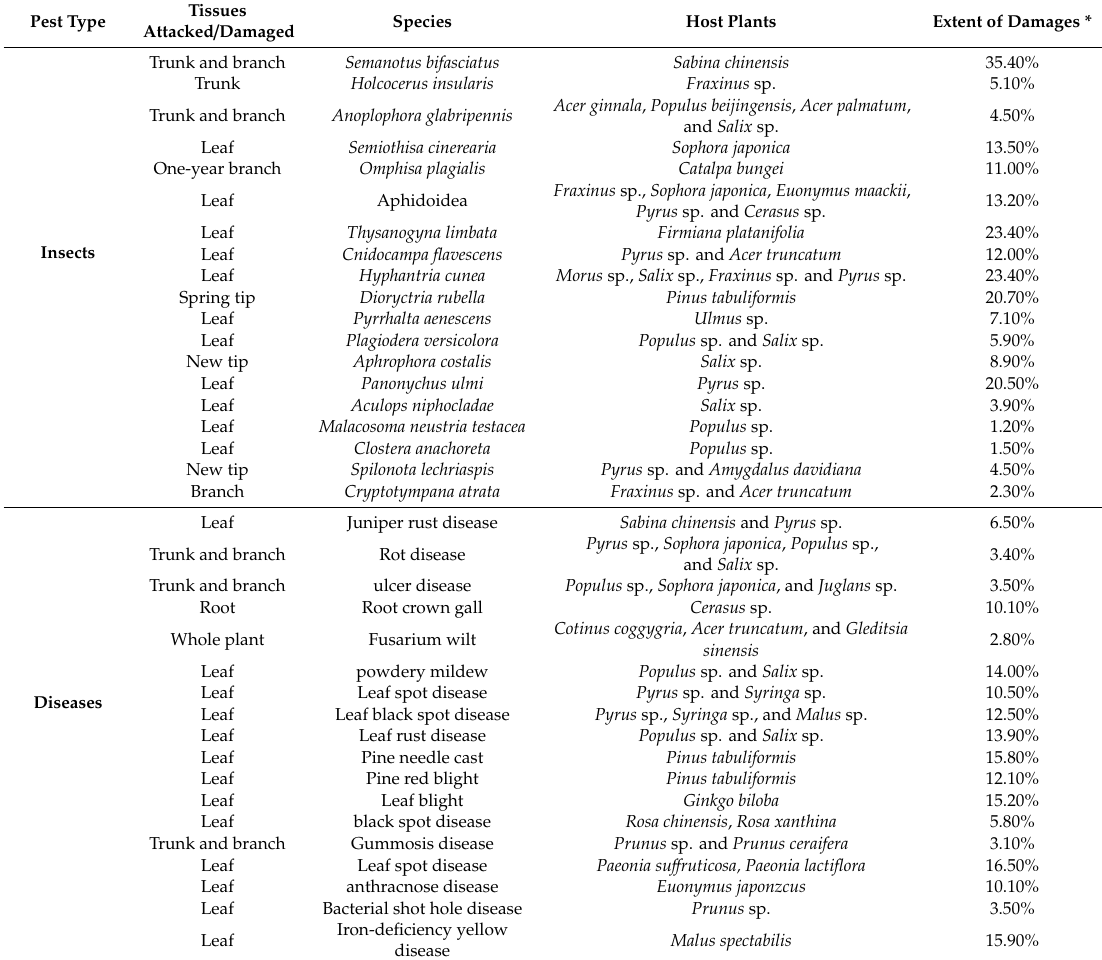
Table 2. Existing pests, including insects and diseases, in Xiongan New